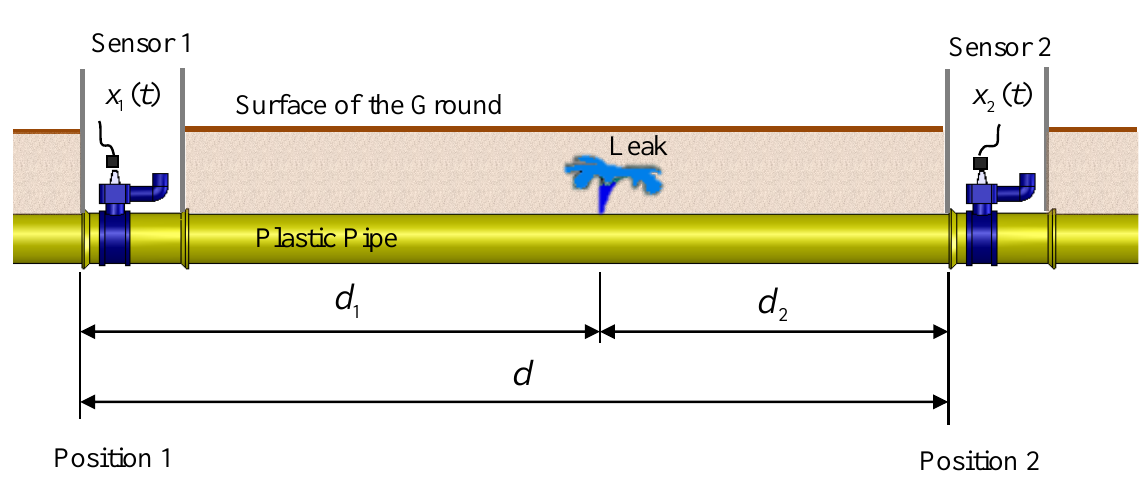
Figure 1. Schematic of buried water pipe in which sensors are positioned at access points either side of a